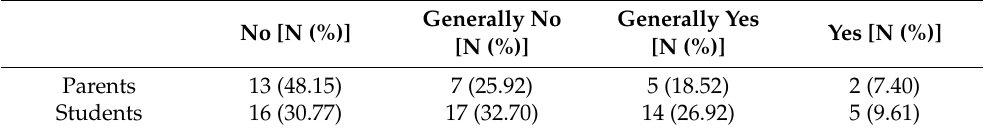
Table 6. Vaccination against COVID-19